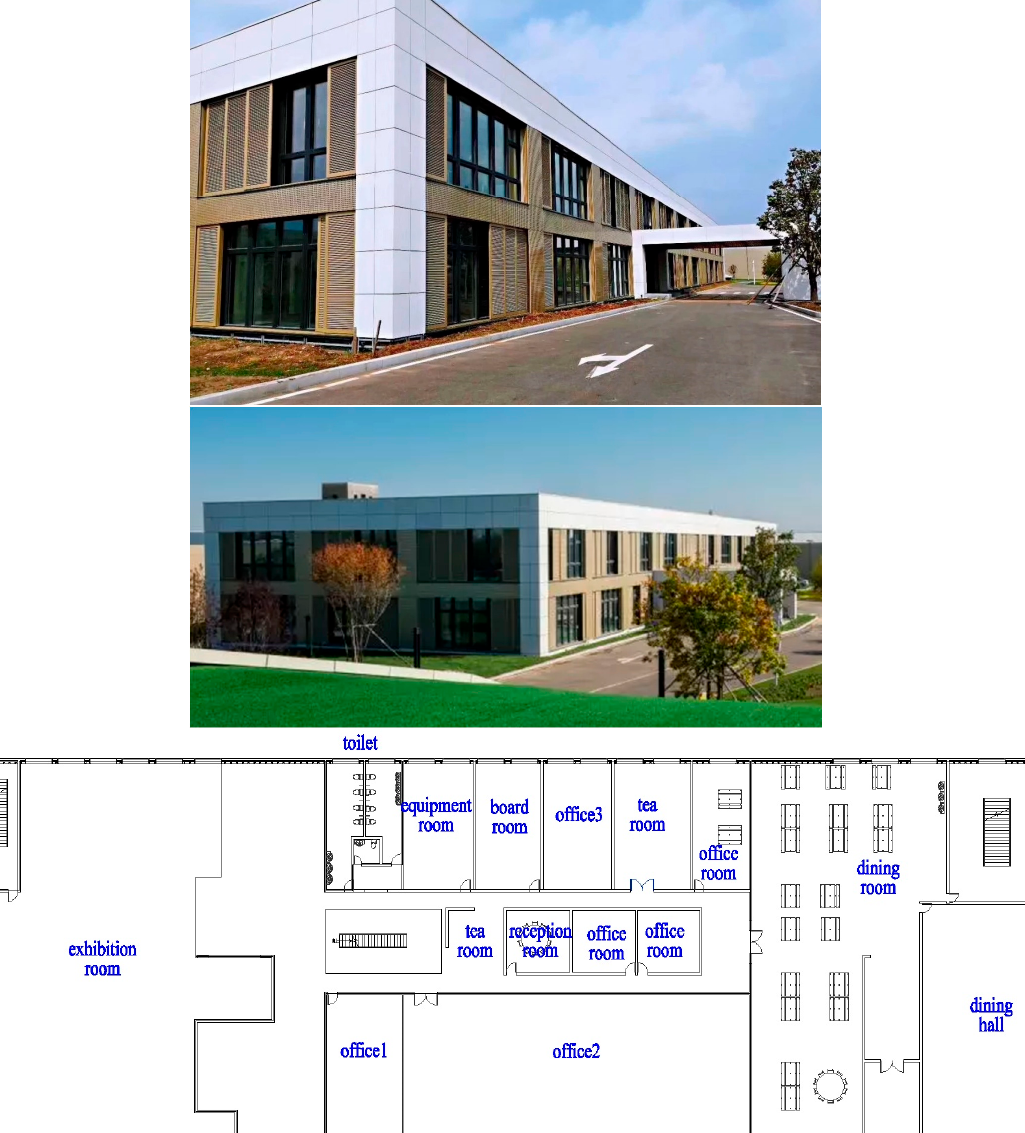
Figure 1. Senying passive office building: close and panoramic photographs (upper and middle panels), and ichnography of the first floor (bottom panel).